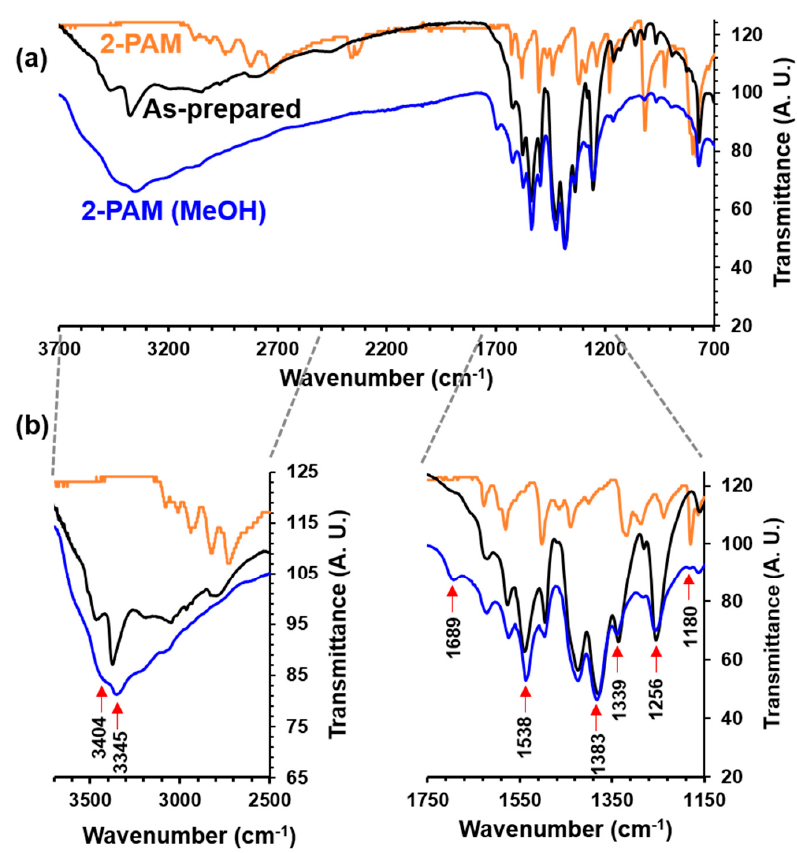
Figure 3. ( a ) FTIR spectra after drying at 100 ◦ C for 2 h of the MIL-125-NH 2 NPs, 2-PAM@MIL-125-NH 2 and the free 2-PAM drug; and ( b ) Selected spectral regions highlighting the main differences between MIL-125-NH 2 and 2-PAM@MIL-125-NH 2 .